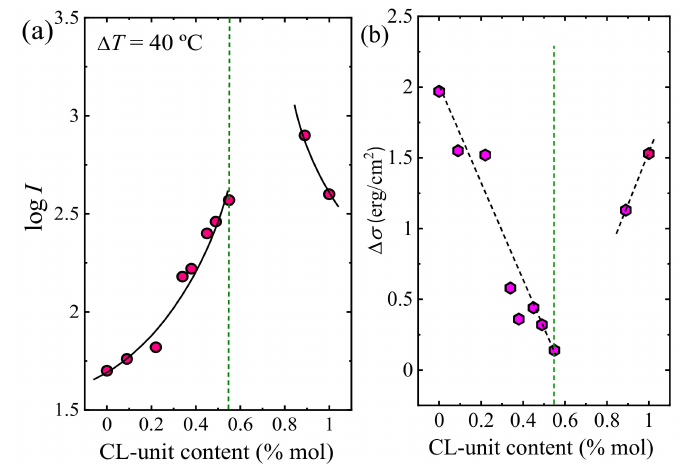
Figure 11. ( a ) Log I (nucleation rate) as a function of copolymer composition taken at a constant supercooling of ∆ T = 40 ◦ C for MMw copolymers. ( b ) Interfacial free energy difference ( ∆ σ ) values as a function of CL-unit composition. The dashed vertical lines indicate the pseudo-eutectic composition. Data reported in ref.